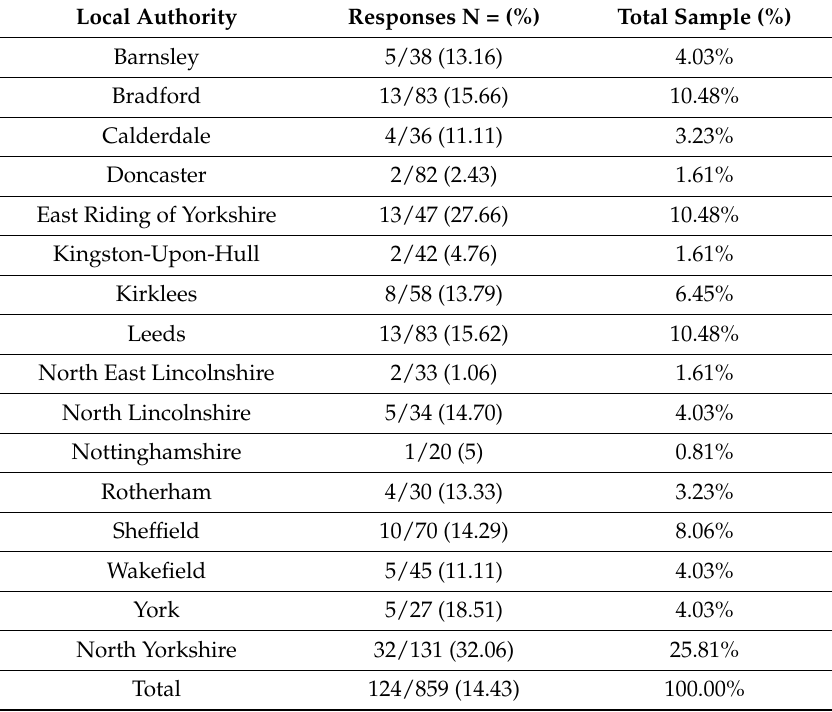
Table 1. Response rate by